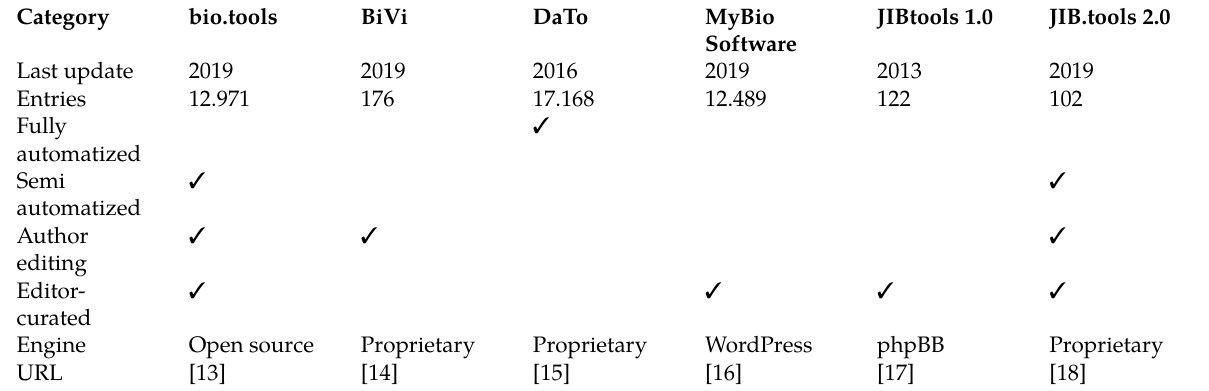
Table 1: The table shows an overview of the different tool lists discussed here (Reference Date: